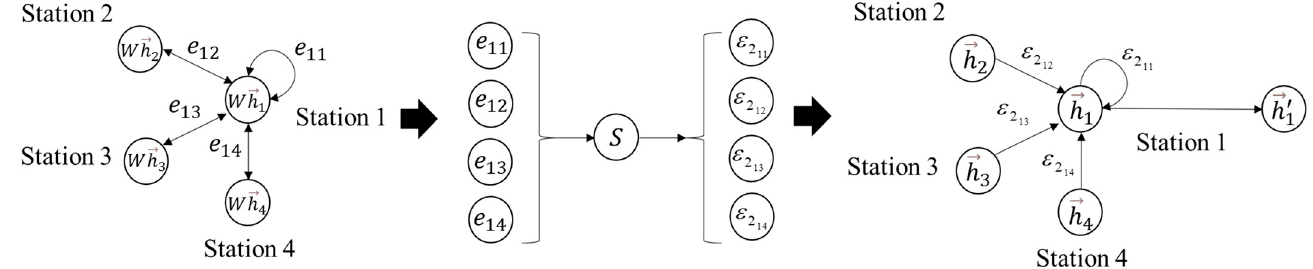
Figure 3. An example to describe how to obtain the passenger flow coupling strengths by GAT. 𝑊 is a weight matrix for linear transformation. 𝑆 is the softmax function for normalization. a weight matrix for linear transformation. S is the softmax function for